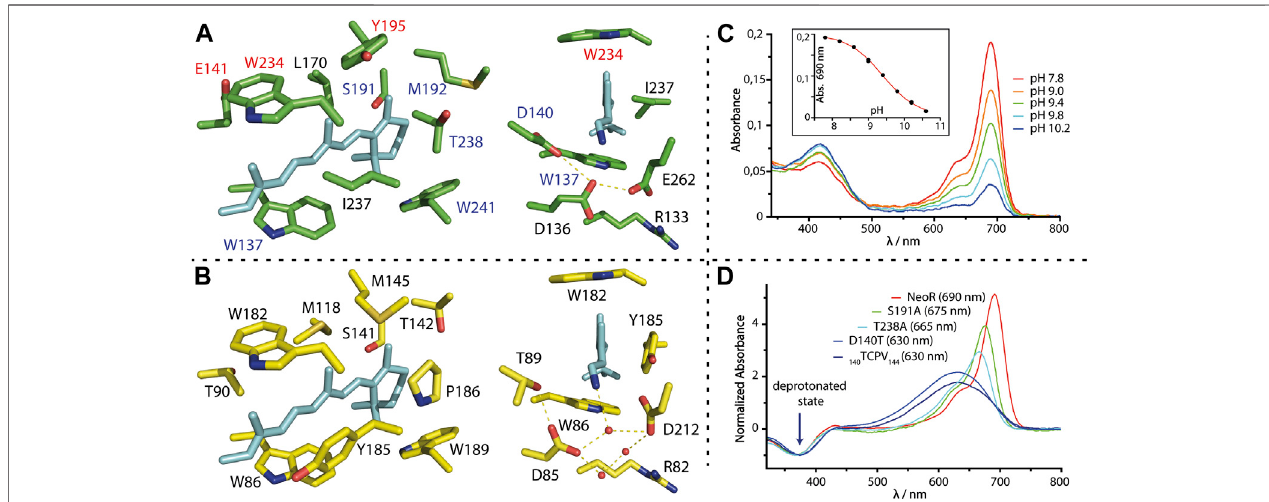
FIGURE 4 | (A,B) Retinal binding cavity residues of NeoR (green) and BR [yellow, 2NTU (Lanyi and Schobert, 2007)]; NeoR homology model is based on the structure of RhoPDE [7CJ3 (Ikuta et al., 2020)]. Right: View towards the RSBH + counterion-complex with water molecules (red spheres) and hydrogen bonds